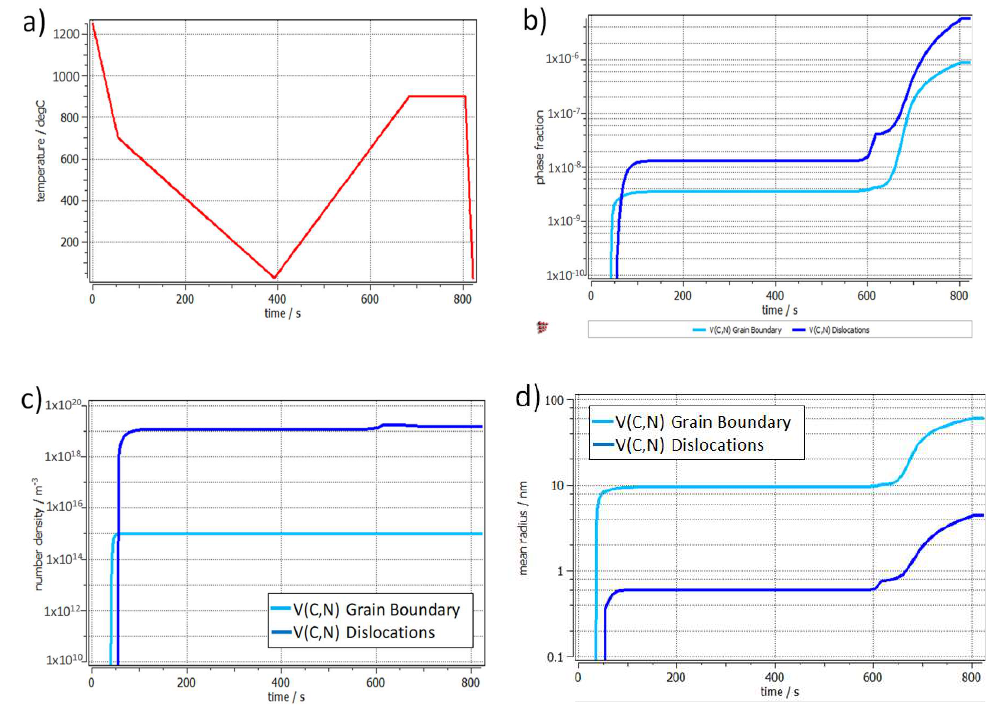
( b ) Calculated phase fractions of V(C,N) nucleated on GB and dislocation sites. ( c ) Precipitate number densities. ( d ) Mean